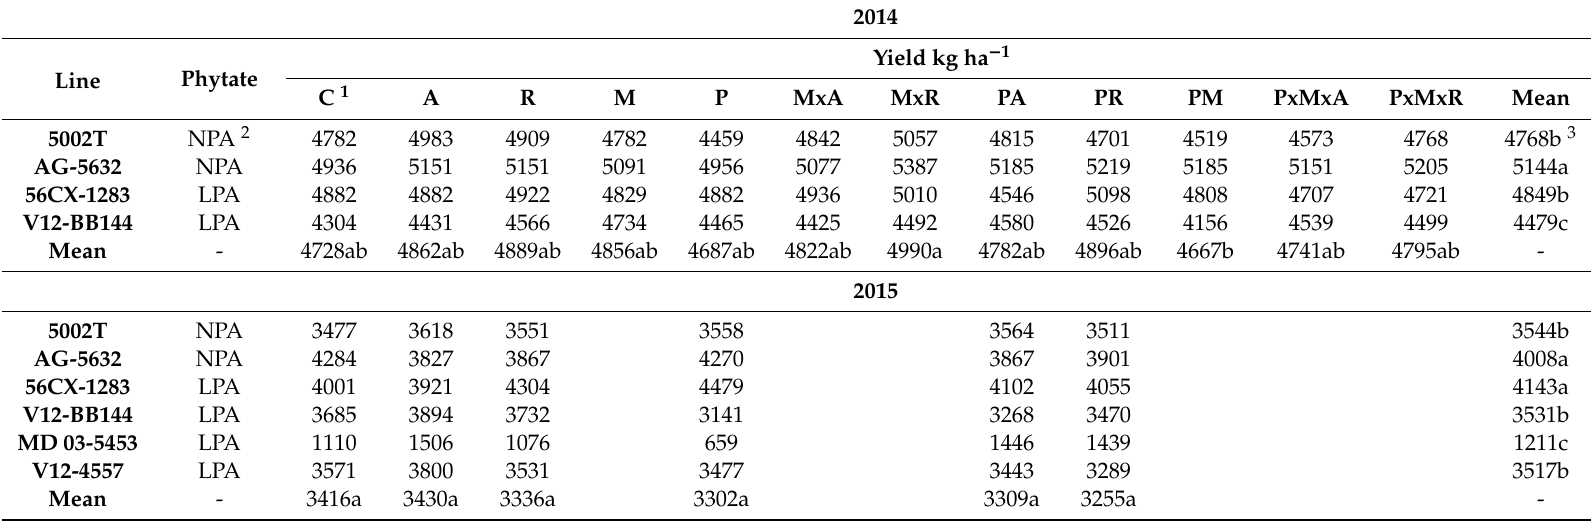
Table 6. E ff ects of seed treatments on yield of six soybean lines grown at Blacksburg and Orange and Tukey’s separation of means in 2014 and